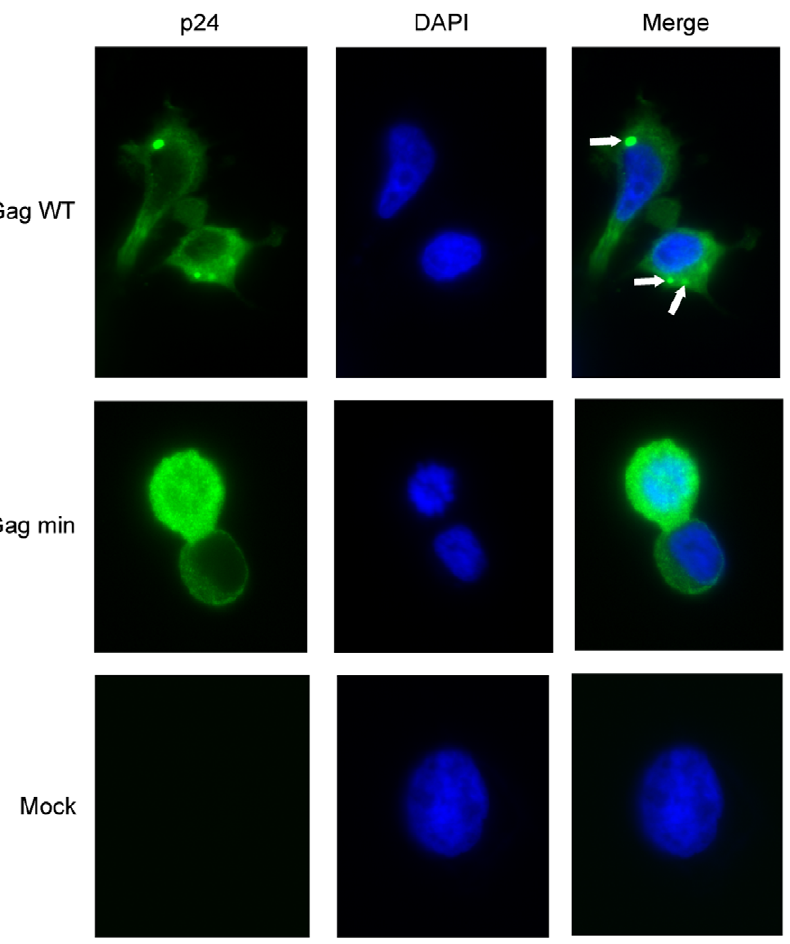
Figure 3. Gag min proteins show a diffuse distribution pattern. 293T cells were transfected either withGag WT(upperpanels),Gag min (middle panels) orpcDNA3.1( + ) vector (bottom panels). At 48 h post-transfection, cells werefixed and permeabilized for immunofluorescenceassays asdescribed in Materials and Methods . Nuclei were stained with DAPI. White arrows indicate a punctiform distribution of Gag proteins. The samples were visualized with a Nikon eclipse TE 300 inverted microscope (magnification: x 1,000). The experiment shown is representative of 3 independent experiments.